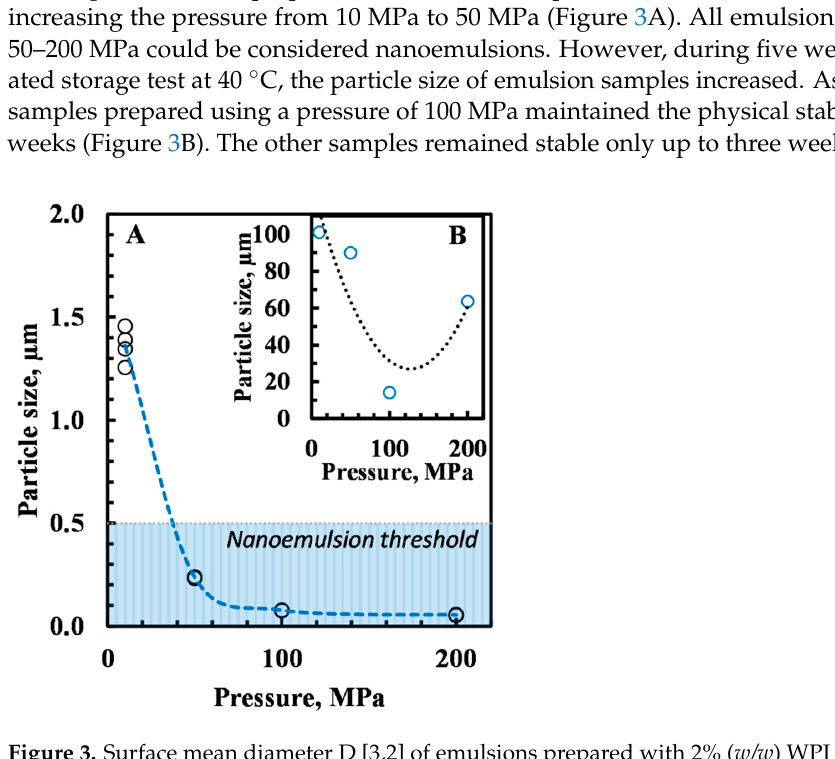
Figure 2. Turbiscan stability index (TSI) obtained for the emulsion samples prepared with 0.1% ( a ); 1% ( b ) and 2% ( c ) WPI ( w/w ) at a pressure of 100 MPa and three microfluidizer cycles.